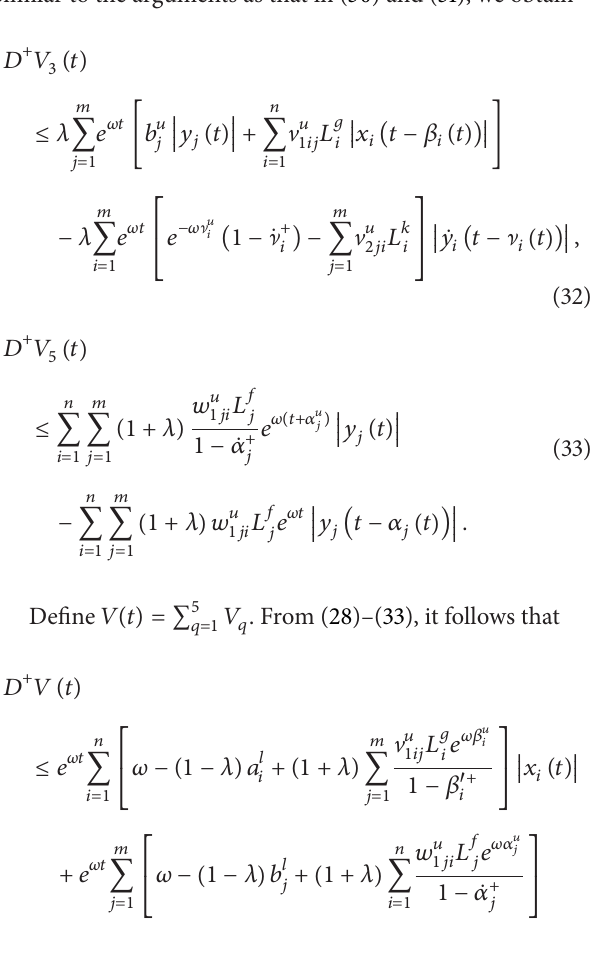
Figure 2: Stability of state variables 𝑥(𝑡)